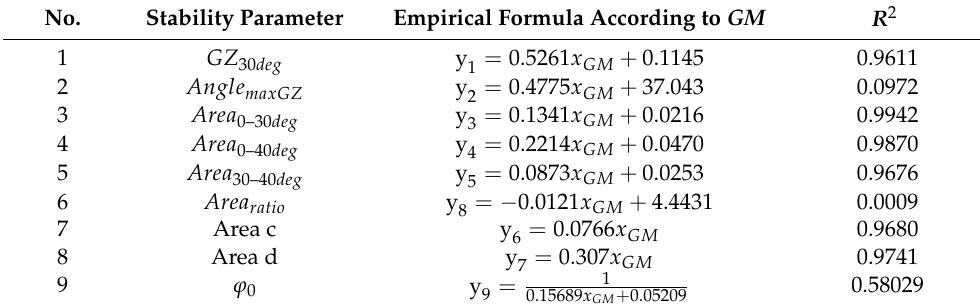
Table 4. Empirical formulas according to GM